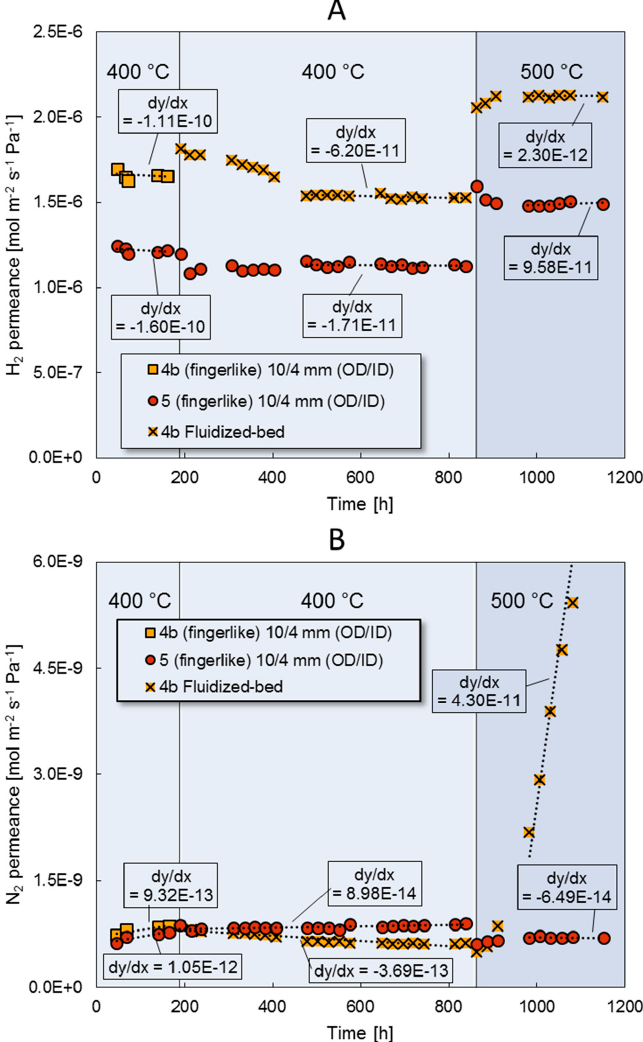
Figure 9. Hydrogen permeance ( A ) and nitrogen permeance ( B ) of membrane 4b in the fluidized bed and membrane 5 in the empty